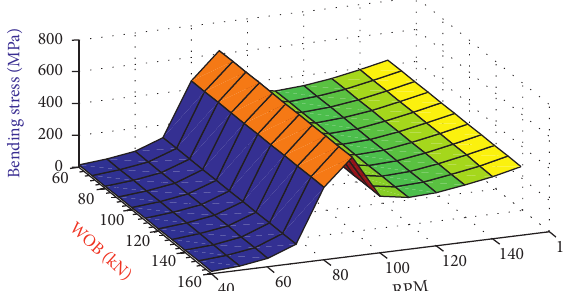
Figure 8: Schematic diagram of RPM-WOB-bending stress.